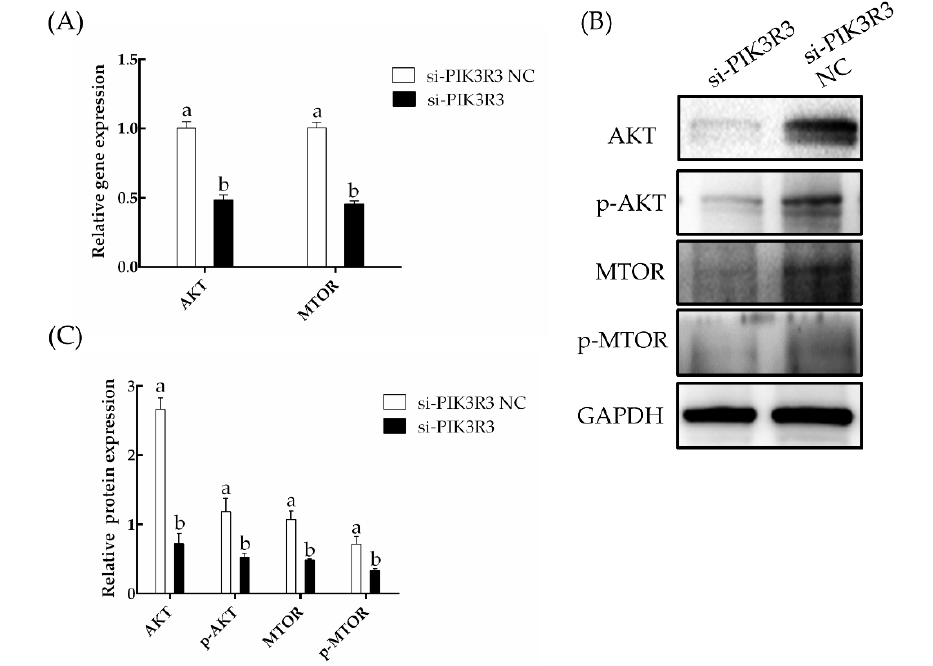
Figure 4. Effect of interfering with PIK3R3 expression on AKT/MTOR signaling pathway. The different small letters (a, b) in the same graph indicate that the difference between groups is statistically significant ( p < 0.05). ( A ) After 24 h of transfection, the expression of AKT and MTOR gene was detected by RT-qPCR. ( B , C ) Relative expression of proteins to GAPDH in HFSCs.